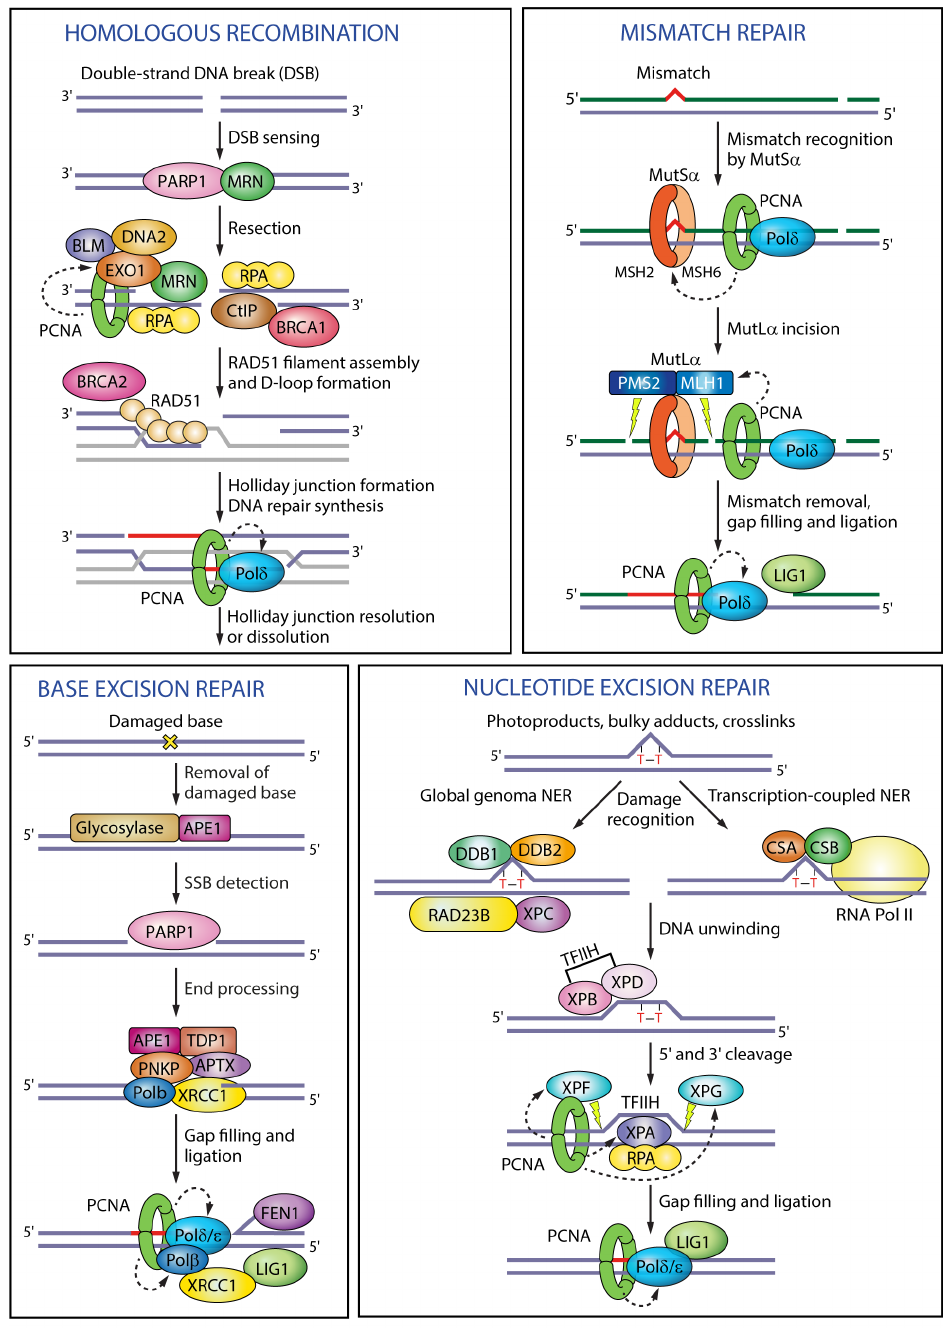
Figure 3. Functions of PCNA in different DNA repair pathways . In homologous recombination PCNA enhances the processivity of the exonuclease EXO1 during end resection and of Pol δ during DNA repair synthesis. In mismatch repair, PCNA interacts with MutS α to recognize the mismatch, activates the endonuclease activity of MutL α to excise the mismatch, and recruits polymerase δ for DNA repair synthesis. In base excision repair, PCNA recruits polymerases β , δ or ε to displace the damaged base into a flap intermediate. In nucleotide excision repair PCNA interacts with the scaffold protein XPA, activates the endonuclease XPF, targets XPG for degradation and recruits polymerase δ to fill in the gap. Black dashed arrows indicate PCNA targets in different pathways. RPA (replication protein A);